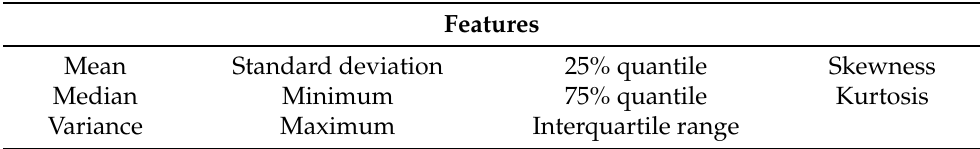
Table 1. Features used for classification.